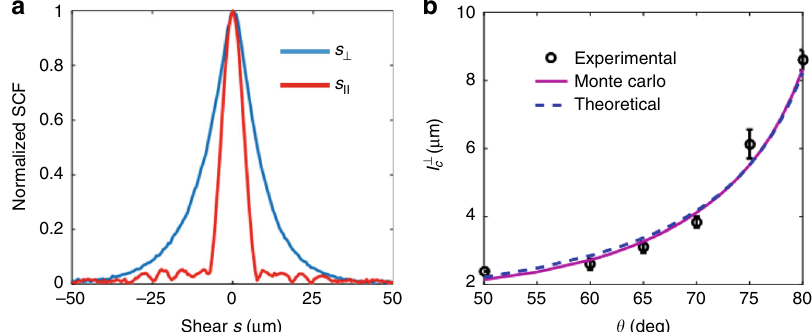
Fig. 3 “ Glitter path ” effect in re fl ection from random media. a Experimental values of the normalized spatial coherence for in-plane s || and off-plane s ⊥ shear corresponding to 80° incidence angle. b Experimental and simulated values of the off-plane coherence length l ? as a function of the angle of incidence θ . c Both the source and detection system are located 1 m away from the multiple-scattering wall. The procedure of measurement is detailed in Supplementary Note 3. The solid line represents the Monte Carlo fi t to the experimental data from which the average slope of the surface roughness was estimated to be σ = 0.07 rad. The dashed line is the corresponding analytical expression l ? / σ cos θ ð Þ (cid:3) 1 . The coherence length (half-width at half-maximum of SCF) of the c fi eld incident on the wall is 132 µ m. The error bars represent the standard deviation of four independent measurements of coherence